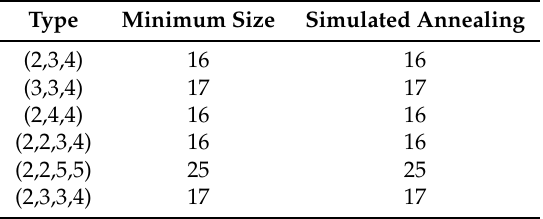
Table 3. Lower bounds on the size of ( ¯1,2 )